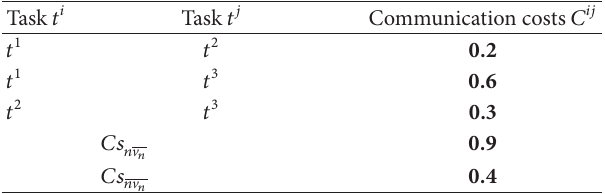
Table 8: Low slowdown. Communication configurations.